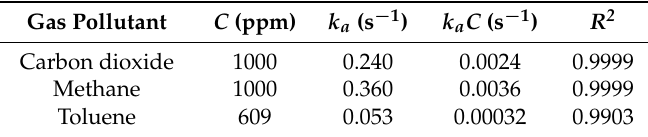
Table 2. Adsorption parameters and model errors.